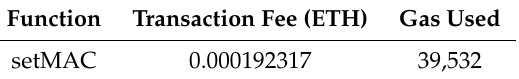
Table 4. Device contract cost.